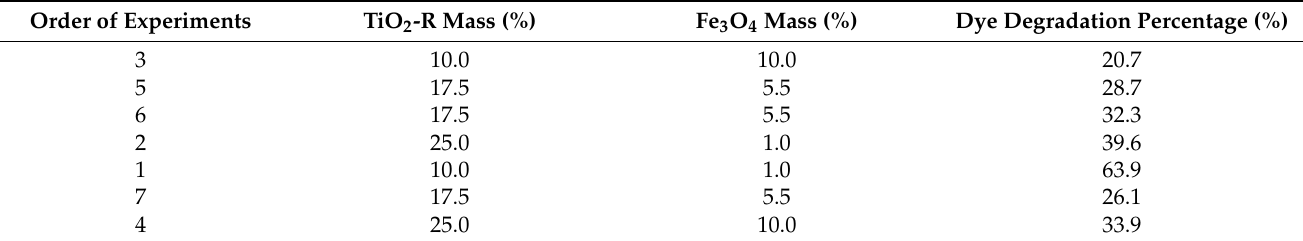
Table 2. Matrix of the 2 2 experimental